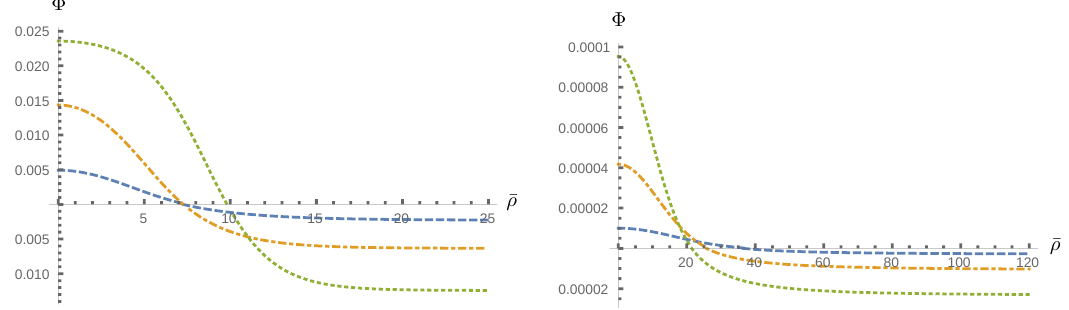
Figure 1 . Representative curves of the potential for three different values of the dimensionless temperature: ¯ T = 0 . 8 (blue), ¯ T = 1 (orange), ¯ T = 1 . 1 (green). The region where Φ takes positive values does not depend on the temperature, hence the curves overlap.